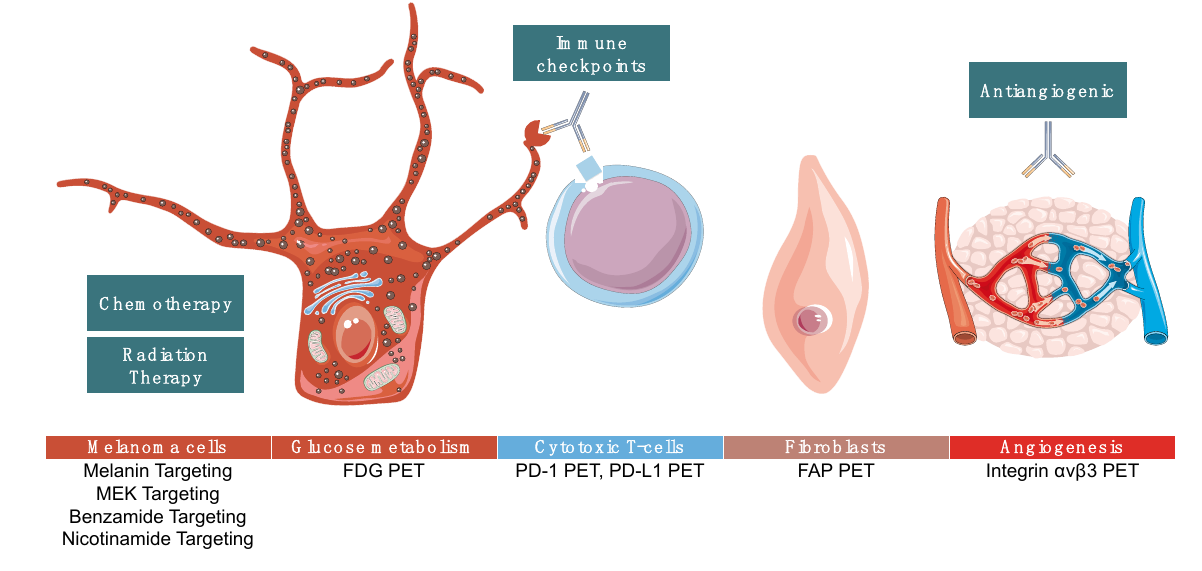
Figure 1. Summarizes targets of positron emission tomography (PET) imaging agents that are in various stages of development as discussed below. Some agents are melanoma-specific while others can be used in many cancer types.